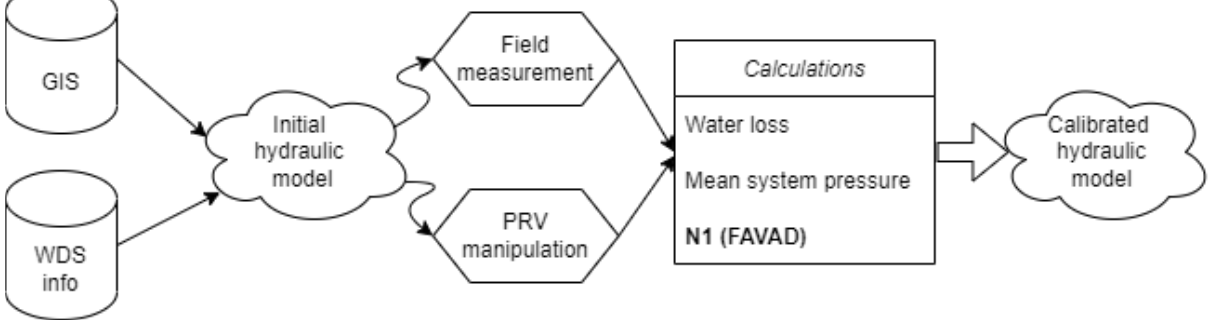
Figure 2. Experiment methodology flowchart.